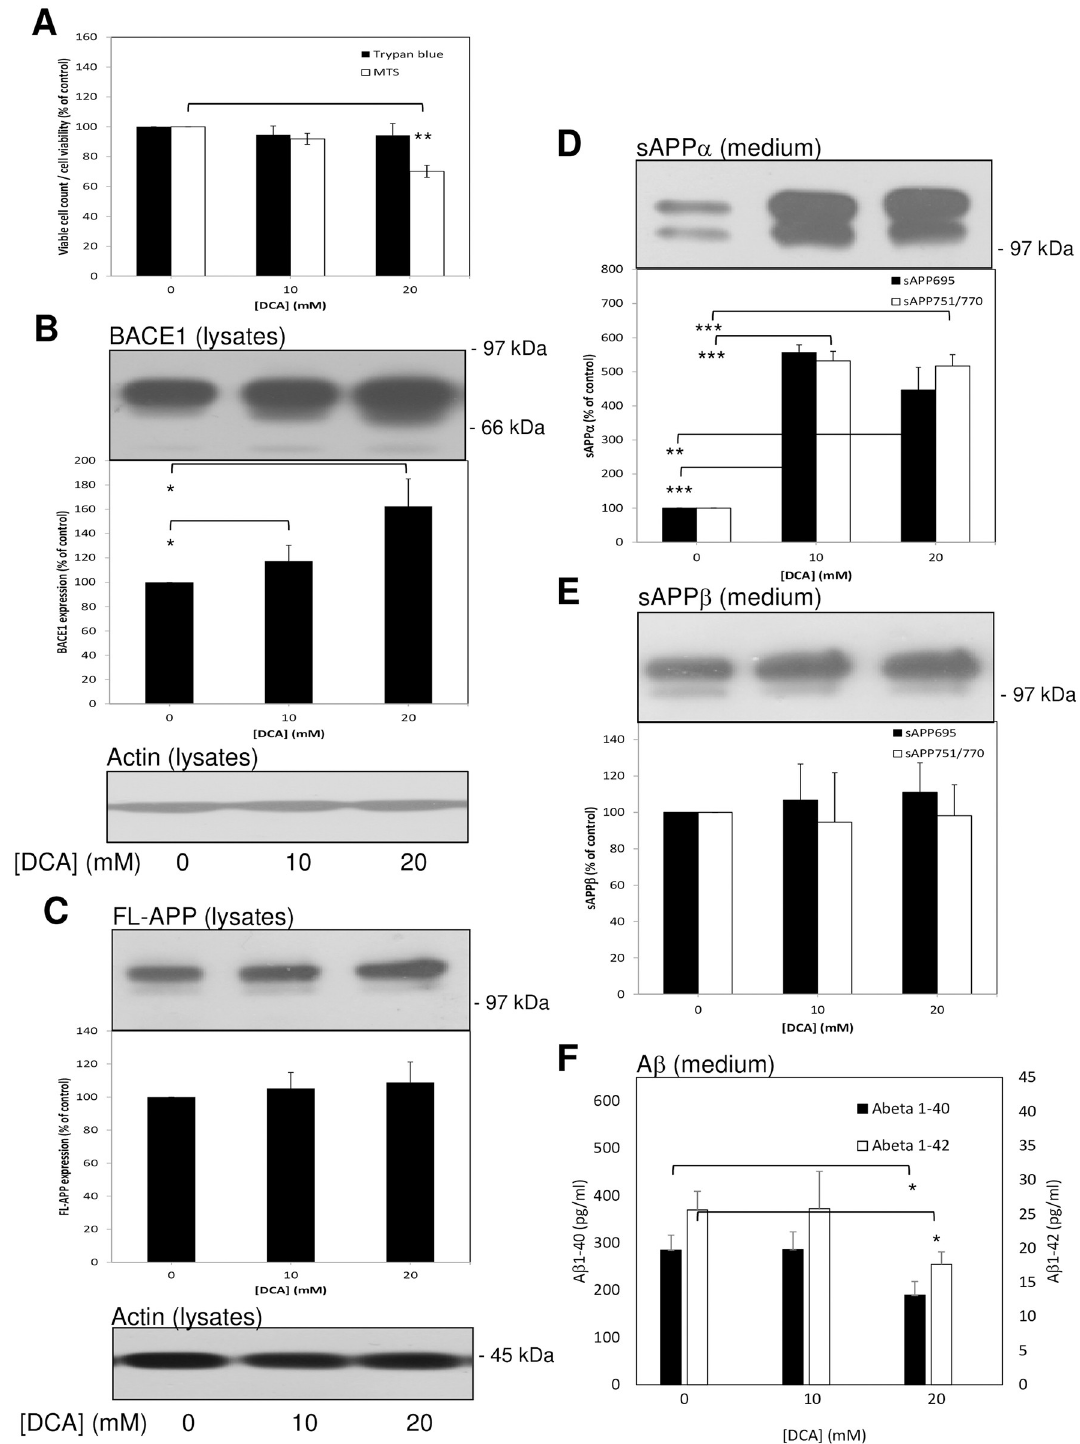
Fig 5. Stable over-expression of BACE1 in SH-SY5Y cells partially ablates the effect of DCA on amyloidogenic but not non- amyloidogenic APP processing. Cells were grown to confluence before replacing the growth medium with UltraMEM containing the indicated DCA concentrations and culturing for an additional 24 h. Viability assays were then performed or cell lysate and conditioned medium samples were prepared as described in the Materials and methods section. Equal amounts of protein (lysates) or equal volumes (medium) from samples were subjected to SDS-PAGE and immunoblotting (Materials and methods). (A) Trypan blue